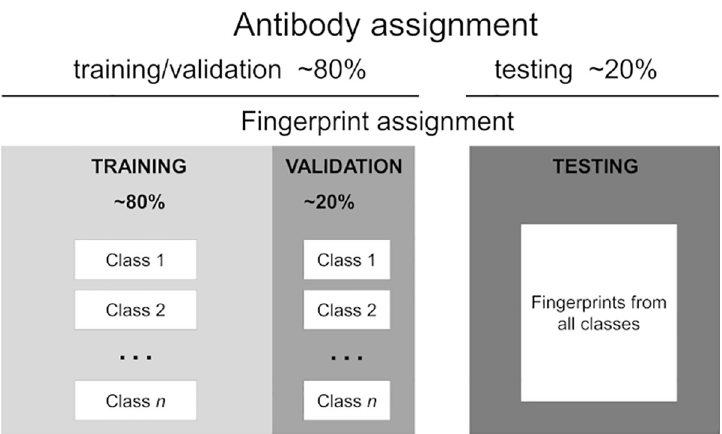
Fig 3. Schematic diagram of the allocation of fingerprints into training, validation, and testing sets. Antibody assignment : Antibodies are randomly split into two fractions: training/validation and testing. Fingerprints assignment : The fingerprint images of an Ab selected for testing are added to a common pool in the test set. If the Ab was selected for training/validation, its fingerprints are divided into two fractions: each fraction is added to specific pools in the training and the validation sets associated with the Ab class.